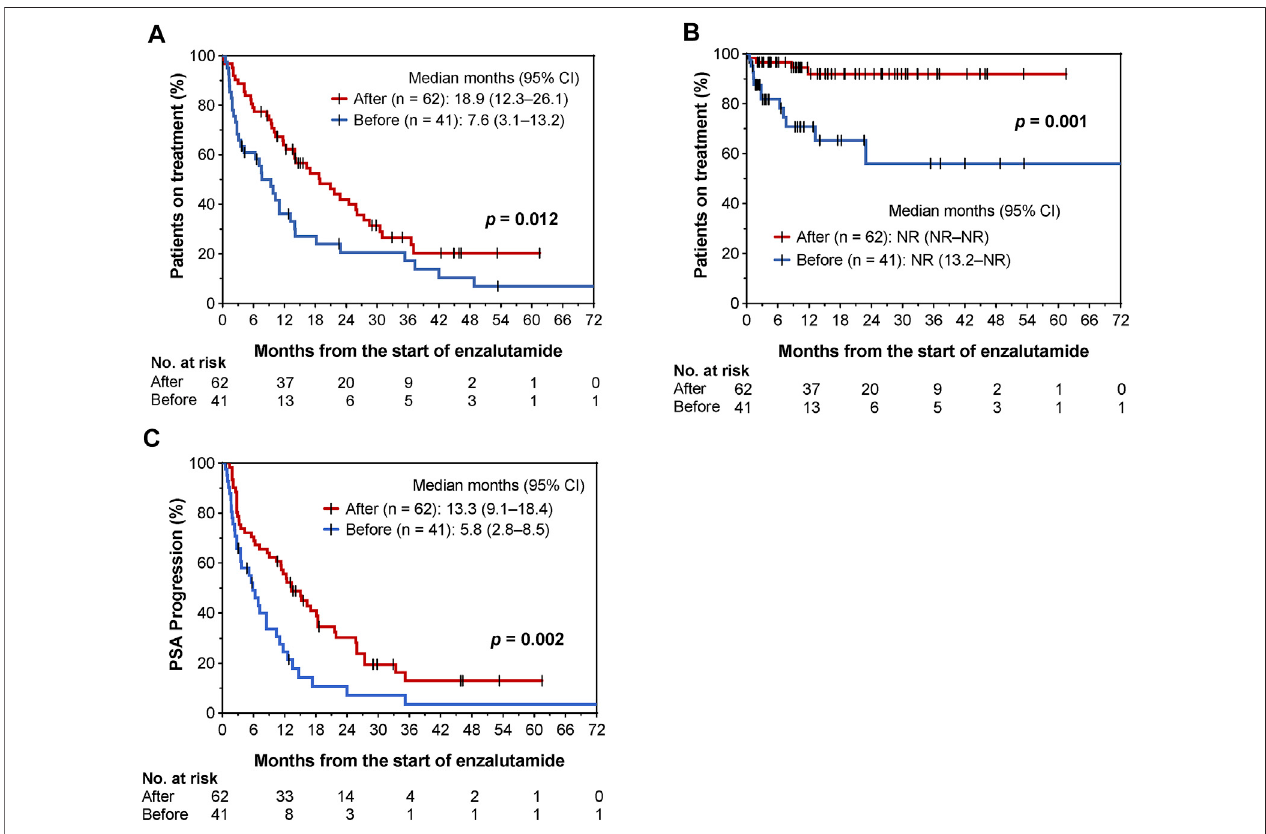
FIGURE 3 | Kaplan – Meier curves for comparisons of time to enzalutamide discontinuation (A) , time to enzalutamide discontinuation due to AEs (B) , and time to PSA progression (C) before and after implementation of pharmacist-urologist collaborative management in patients receiving enzalutamide.